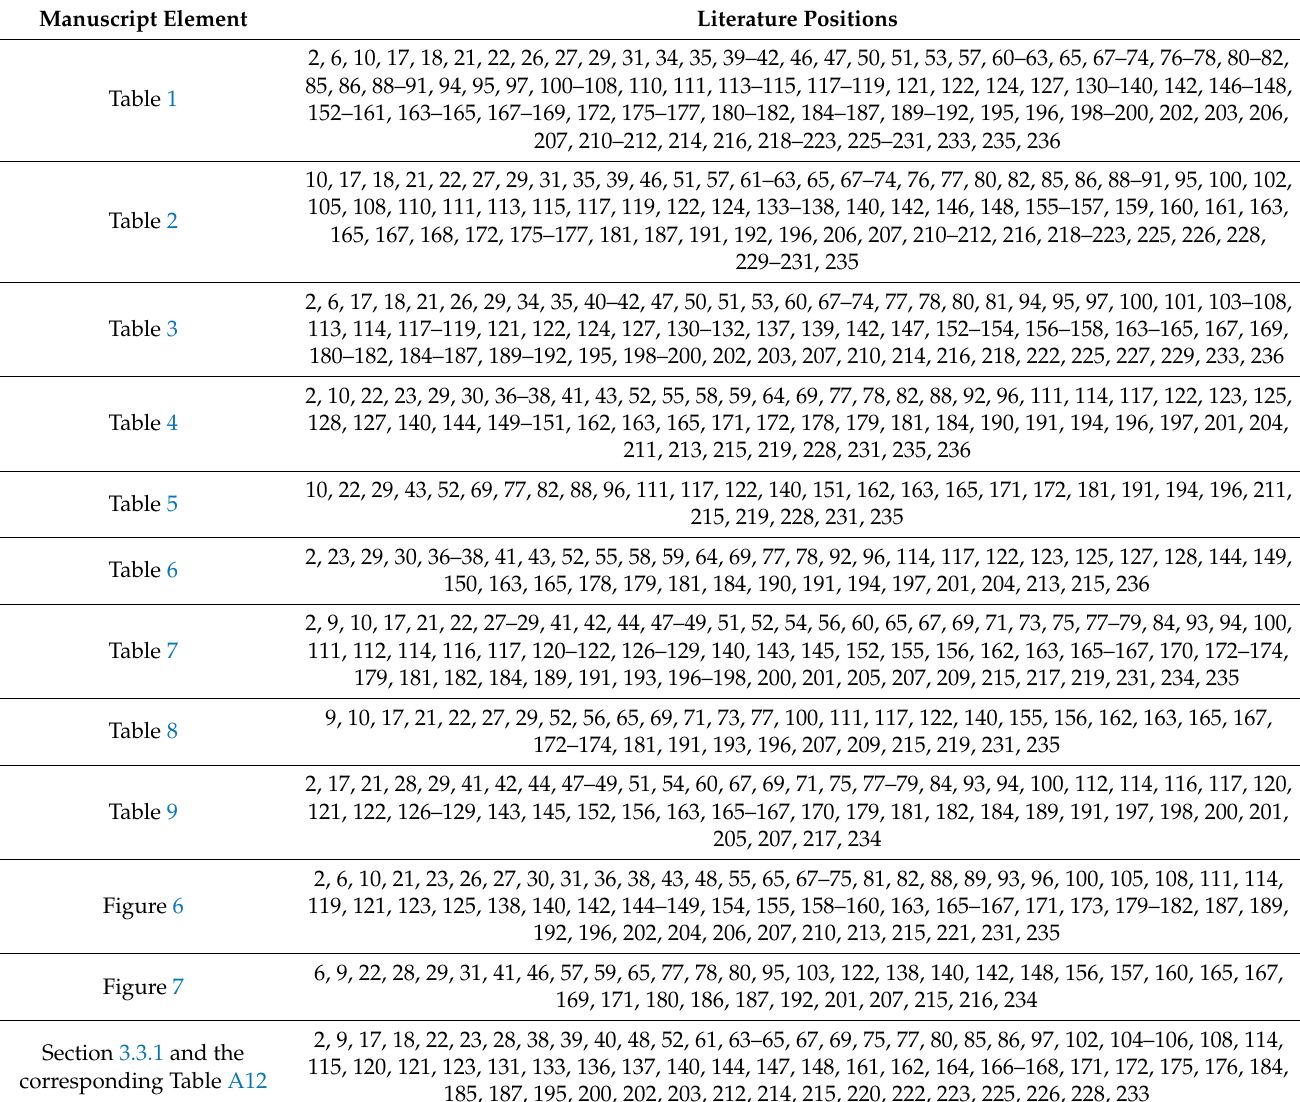
Table A25. Information which literature positions we used during generating the data for manuscript